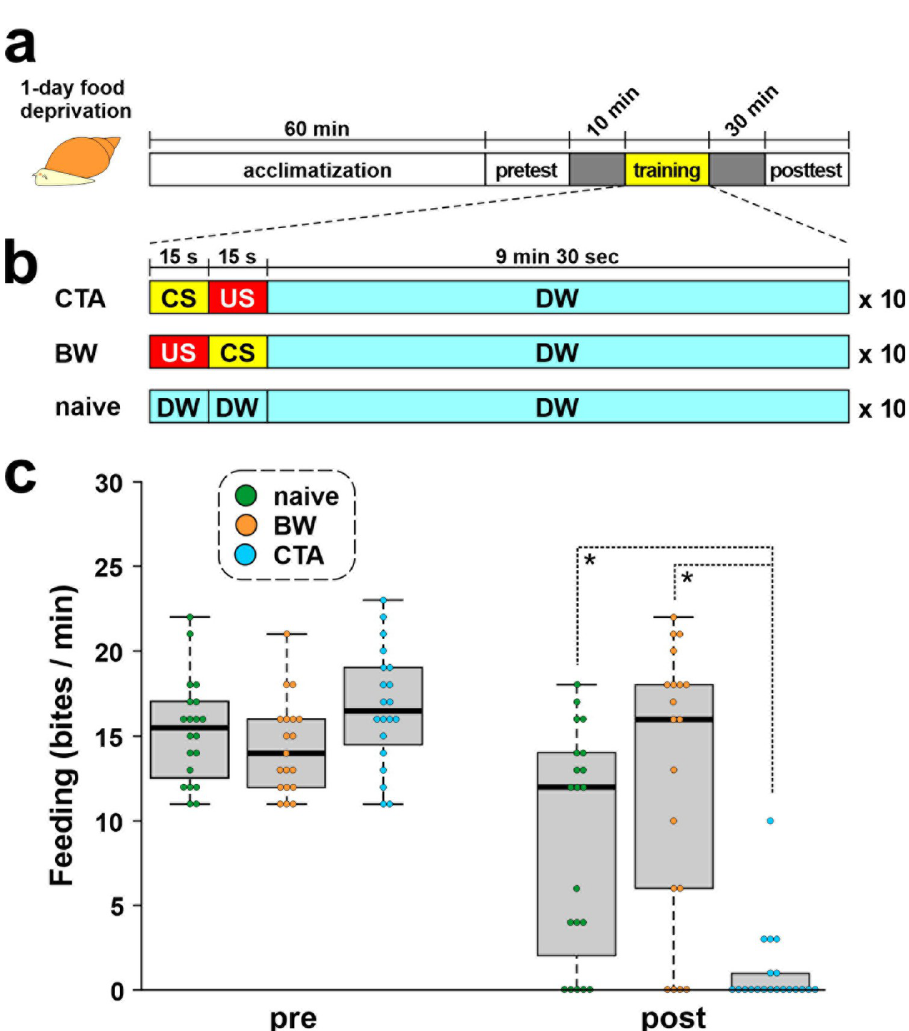
Fig 1. Conditioned taste aversion (CTA) training for Lymnaea . (A) Diagram of the total procedure of CTA. (B) Procedures used for CTA training, backward (BW) training, and na ï ve control. CS: conditioned stimulus (10 mM sucrose solution), US: unconditioned stimulus (10 mM KCl solution). (C) Box-and-whisker plots show the learning and memory scores of CTA (i.e., number of bites to CS) examined at the pretest and posttests. Green, orange, and blue dots show na ï ve-control, BW-trained, and CTA-trained snails, respectively. The number of snails was at least 10 in each condition. � p < 0.05 by Holm’s post-hoc test. pretest, training, and posttest were performed in a polystyrene petri dish (diameter 35 mm) [34]. All snails were acclimatized in distilled water (DW) for 1 h and given a pretest (Fig 1A). In the pretest, 2-mL of a 10-mM sucrose solution was applied to the lips of the snail for 15 s as a condi- tioned stimulus (CS), and the number of feeding responses (i.e., rasping movements of the buccal mass) in DW was counted for 1 min. CTA learning in Lymnaea was induced by pairing a 10-mM sucrose solution as the CS and a 10-mM KCl solution as an unconditioned stimulus (US) (Fig 1B). The duration of both the CS and US was 15 s, with a 15-s interstimulus interval between the onset of the CS and the onset of the US. Snails received 10 paired CS-US trials with 10-min inter- trial intervals. To validate associative learning, backward (BW)-training (i.e., US-CS) and na ï ve-control groups were included. For the na ï ve-control group, DW was applied to the lips instead of the